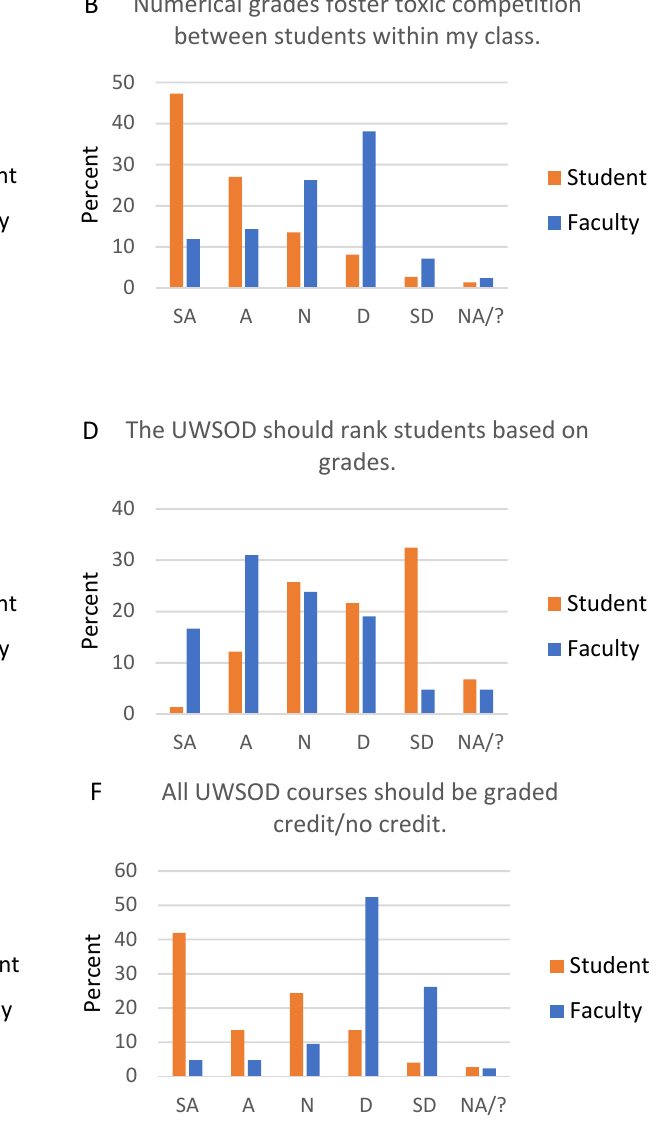
Figure 2. Faculty and student responses regarding grading scales. All students and faculty were asked about numerical and credit/no credit grading scales. Graph titles reflect wording asked of students, but wording was customized for students and faculty. For example, the statement for students was “Numerical grades motivate me to perform my personal best”, and the statement for faculty was “Numerical grades motivate students to perform their personal best”. SA, strongly agree; A, agree; N, neutral; D, disagree; SD, strongly disagree; NA/?, not applicable/don’t know; UWSOD, University of Washington School of Dentistry.